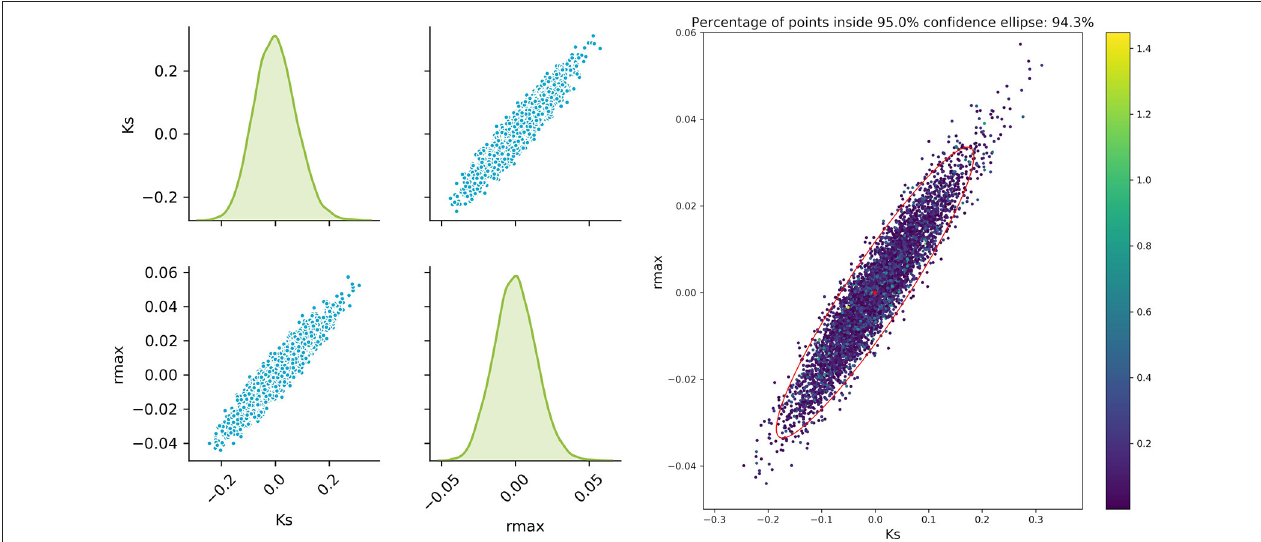
FIGURE 2 | Monte Carlo results for t opt ; Left : pairplots of parameters obtained with a data noise using µ = 0 and σ 2 = 0.16; Right MC vs. FIM.